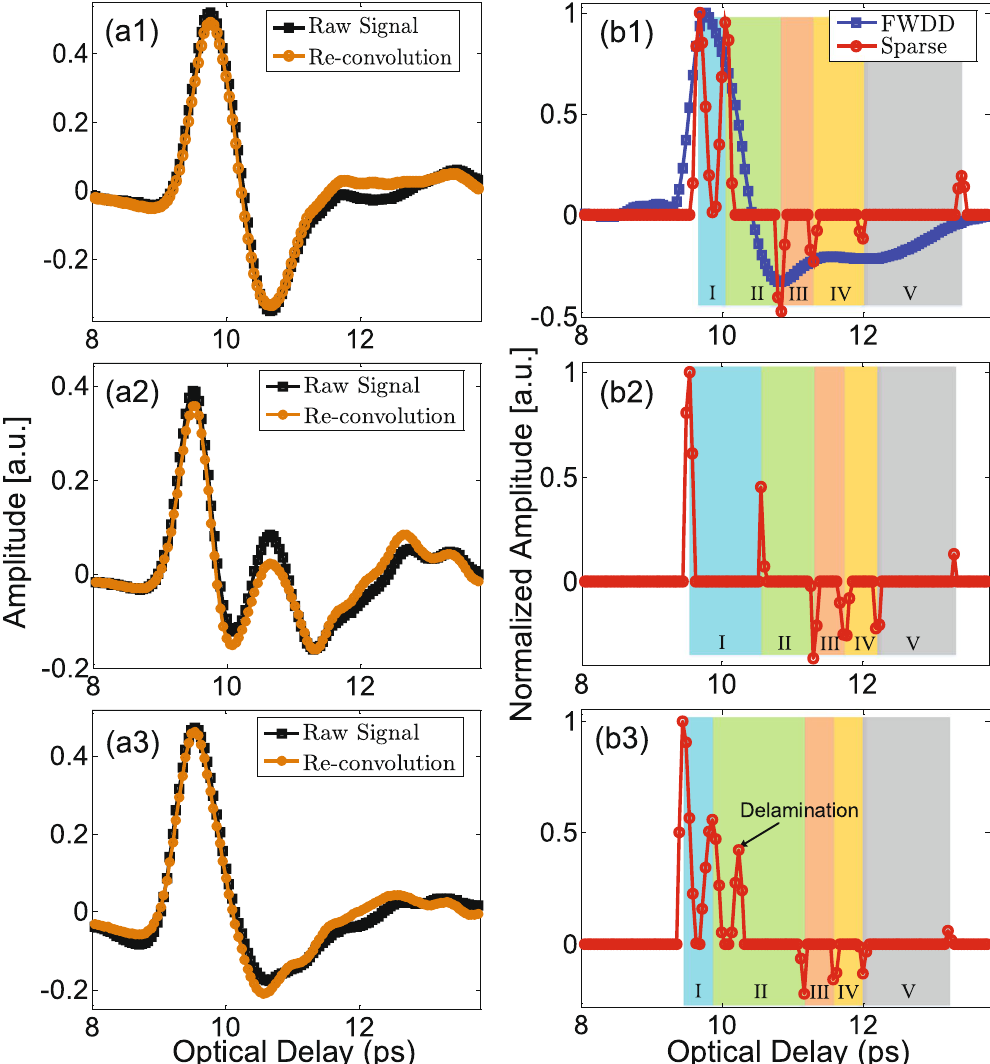
Figure 4. Typical THz reflected signals and the sparsity-based deconvolved signals. Figure 4(a1–a3) show examples of raw reflected signals (black) and signals reconstructed (brown) from the sparse-deconvolution and reference signals. Figure 4(b1–b3) show the corresponding sparsity-based deconvolution signals (red); Fig. 4(b1) also shows the deconvolved signal achieved by FWDD for